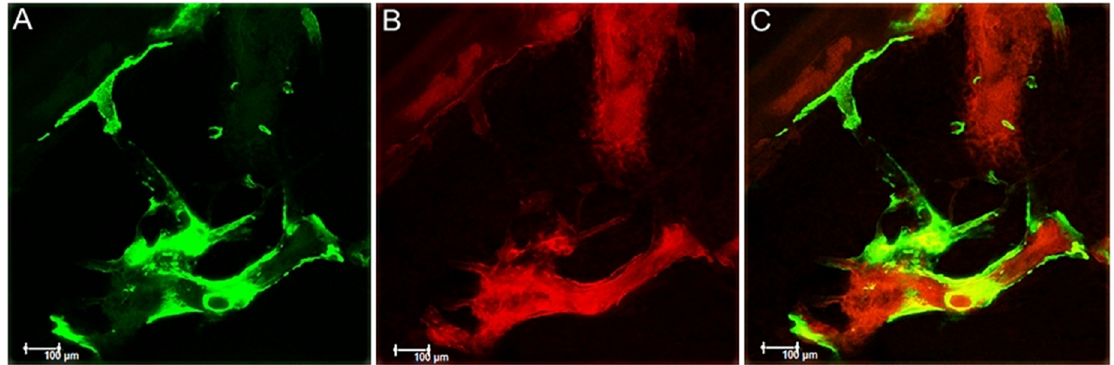
Figure 1- Alveolar bone dynamics by confocal laser microscopy. Representative image of the biomarking of the fluorochromes in the alveolar bone of the maxilla estimated by "Color Selection" tool in the Image J program (Processing Software and Image Analysis, Ontario, Canada). A: Green biomarking of calcein fluorochrome. B: Red biomarking of the alizarin fluorochrome. C: Overlapping of both fluorochromes characterizing the alveolar bone